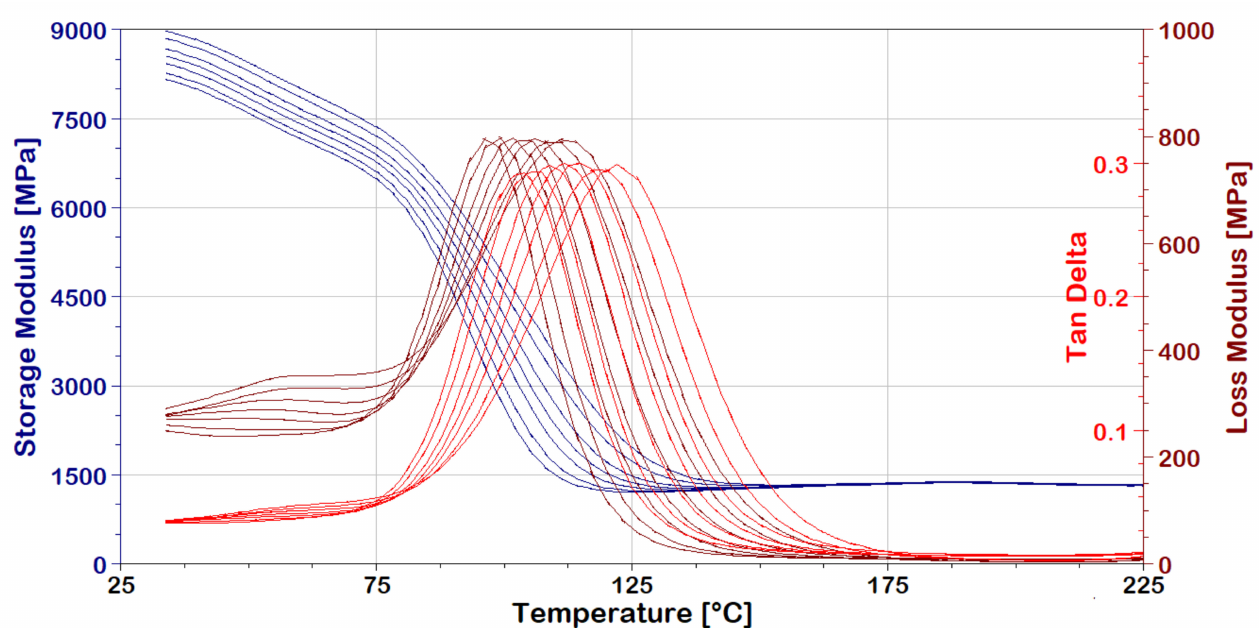
Figure 13. Vectran/aluminum–glass composite hybrid, DMA frequency-temperature